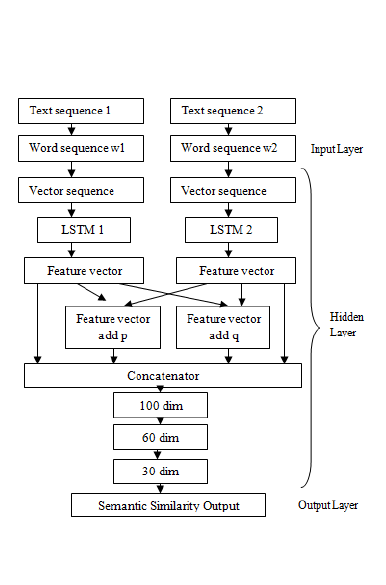
Figure 1. Proposed prototype structural